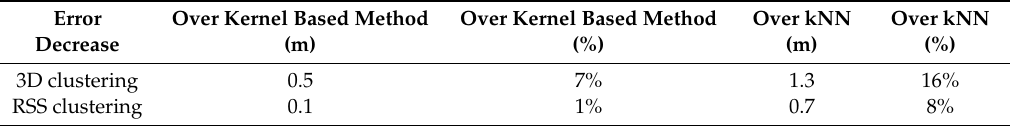
Table 6. The mean error decreasing numbers using compressive sensing over kNN and kernel based methods in building